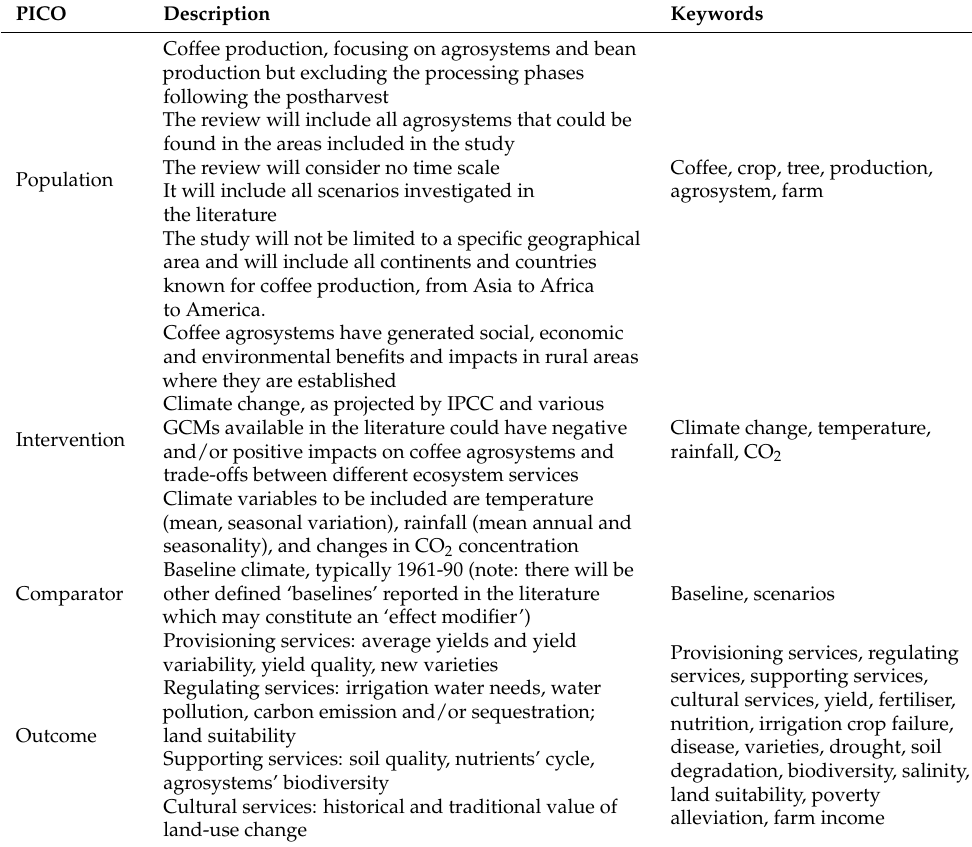
Table 2. The breakdown of the research question into PICO components and related keywords.